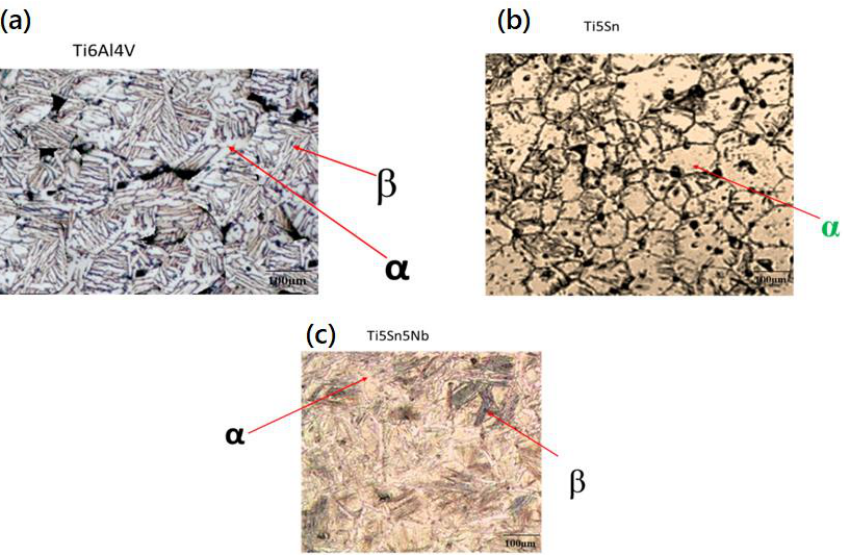
Figure 4. Optical micrographs of the synthesized alloys via powder metallurgy route. ( a ) Ti5Sn5Nb, ( b ) Ti6Al4V, and ( c ) Ti5Sn show alpha and beta regions.